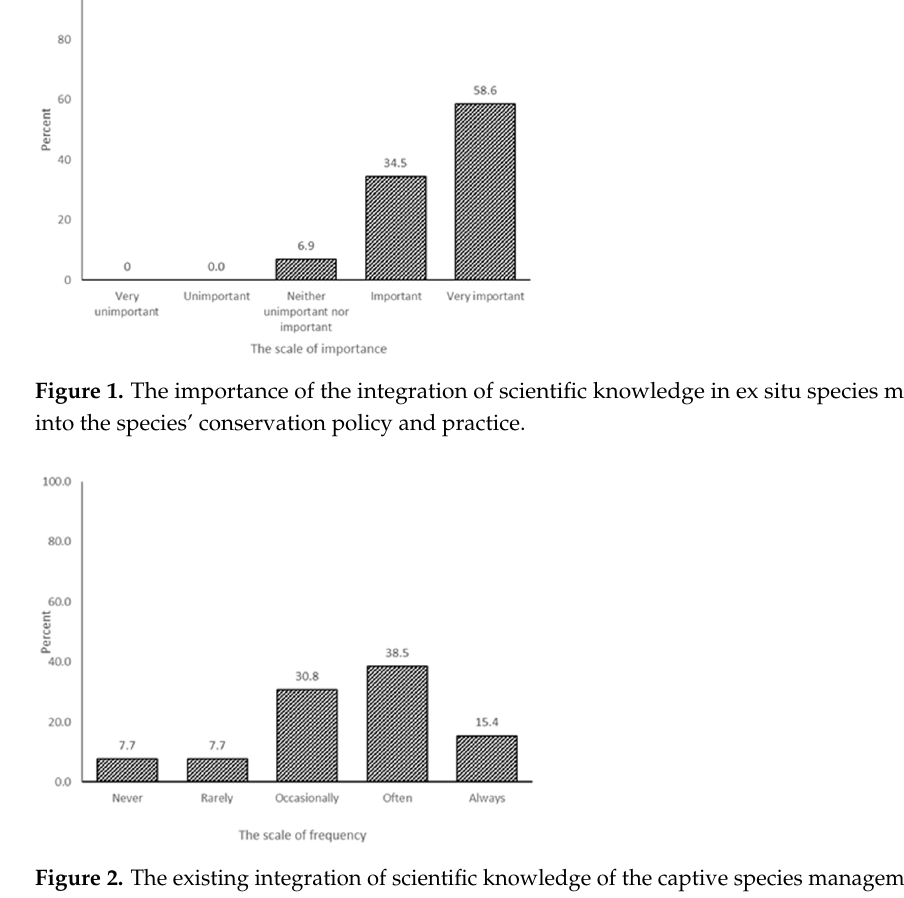
Figure 4. The need for a conservation policy or strategy or a species management plan by the cap- tive animal institution from the animal host country. 3.2. Anthropogenic Disturbances Within about seven decades of persecution and prime habitat loss [22,23], the popu- lation experienced a rapid decline from 3000 individuals in the 1950s down to less than 200 animals in 2019. The Malayan tiger population was estimated at 500 individuals in 1990 [24] and had declined to 250–340 individuals by 2013 [6]. Unfortunately, the drastic trend has continued to nosedive to a critical level of near population crash. The estimated wild Malayan tiger population in 2018 was fewer than 200 individuals [15] (Table 1). Thus, the population lost approximately 60% of the wild Malayan tiger population in the last three decades since 1990. Table 1. Estimated wild Malayan Tiger population in Malaysia. Year Estimate Population/Individuals